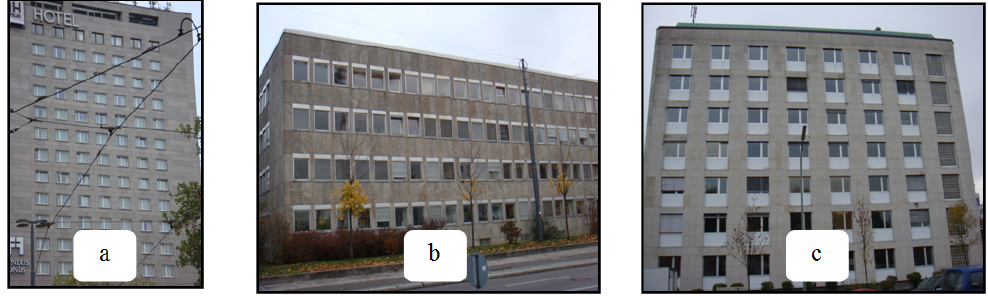
Figure 3. Three different façades with regularly distributed windows. With the ( a ) is a façade of NH hotel in Munich, ( b ) and ( c ) are façades of two normal buildings on Nymphenburg street in Munich.